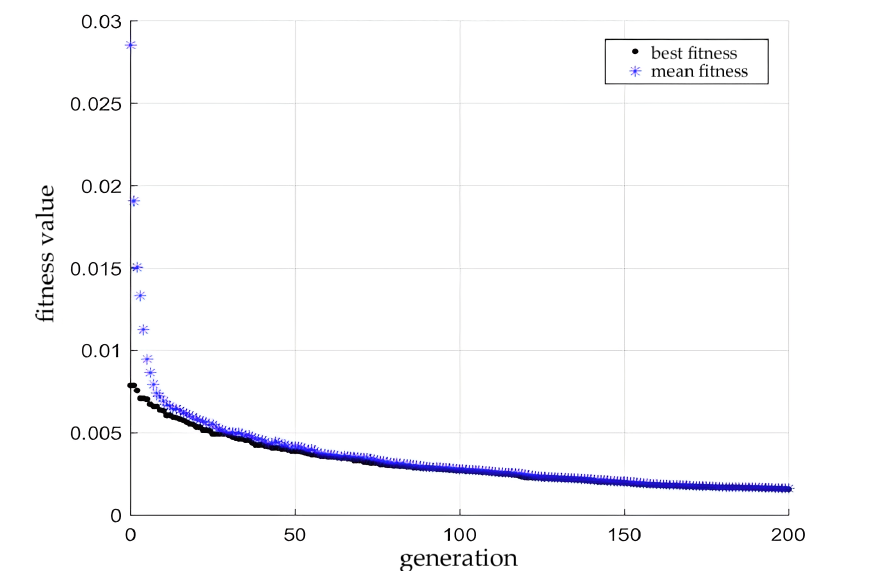
Figure 9. Plot of values for the genetic algorithm PID optimization